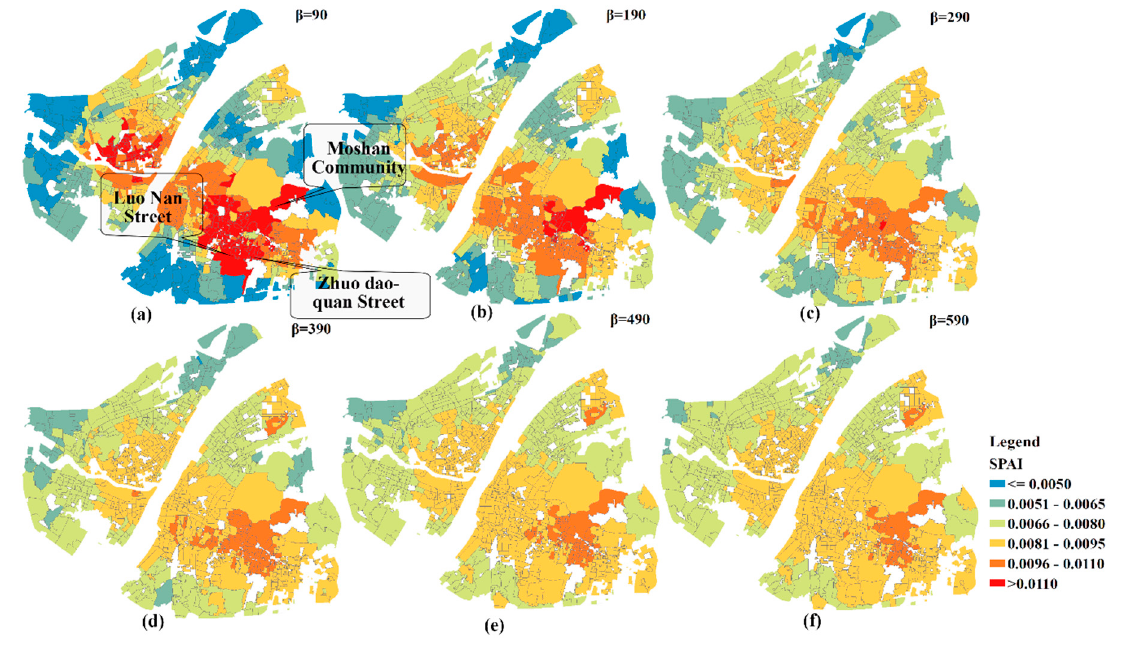
Figure 8. The geographic patterns of SPAI with different β values. ( a ) β = 90; ( b ) β = 190; ( c ) β = 290; ( d ) β = 390; ( e ) β = 490; ( f ) β = 590.